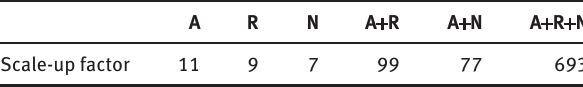
Table 3: Scale-up factors for different